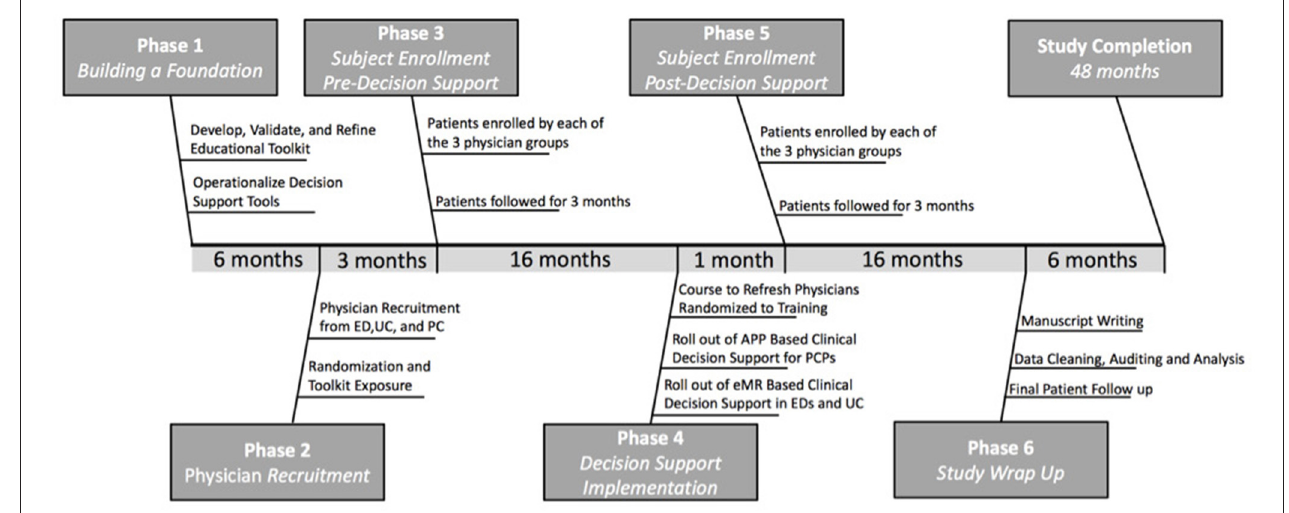
FIGURE 1 | TEaM study